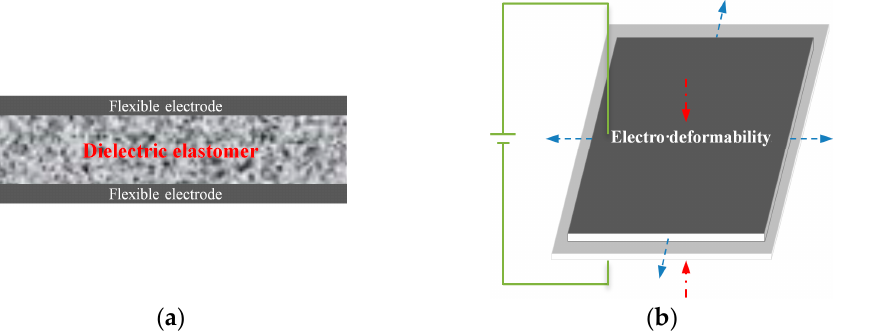
Figure 1. Schematic diagram of the DE actuating unit and its electro deformability. ( a ) Dielectric elastomer actuator, ( b ) Principle of electro deformability.